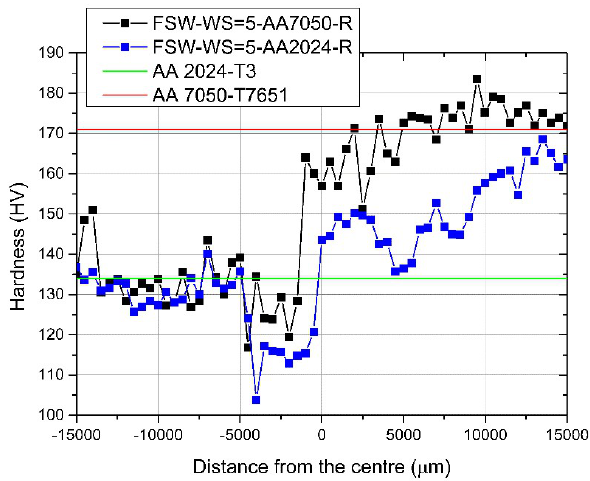
Figure 10. Microhardness test results for WS = 5 mm/s and the different positioning of the materials.